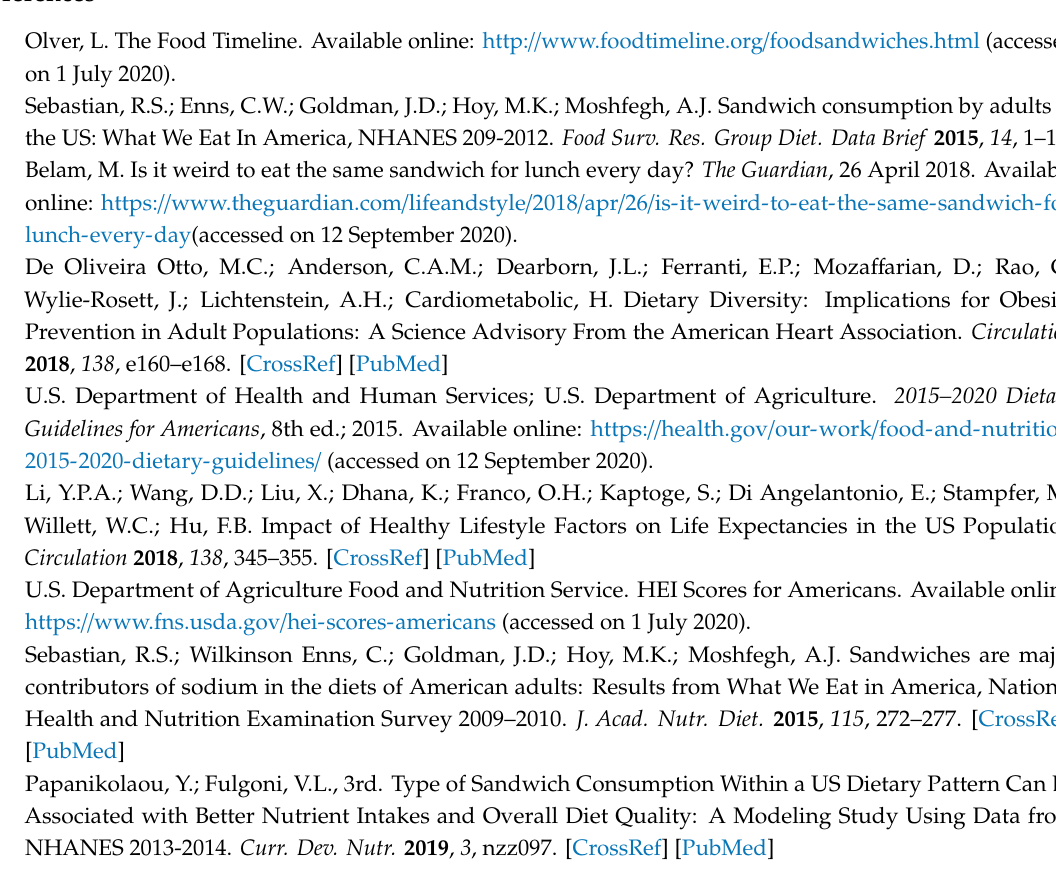
Table S1: Mixed Model Regression Results of Relationship of Energy from Sandwiches with Healthy Eating Index-2010 scores as outcome, Table S2: Change in Healthy Eating Index-2010 scores based on mixed-e ff ect regression